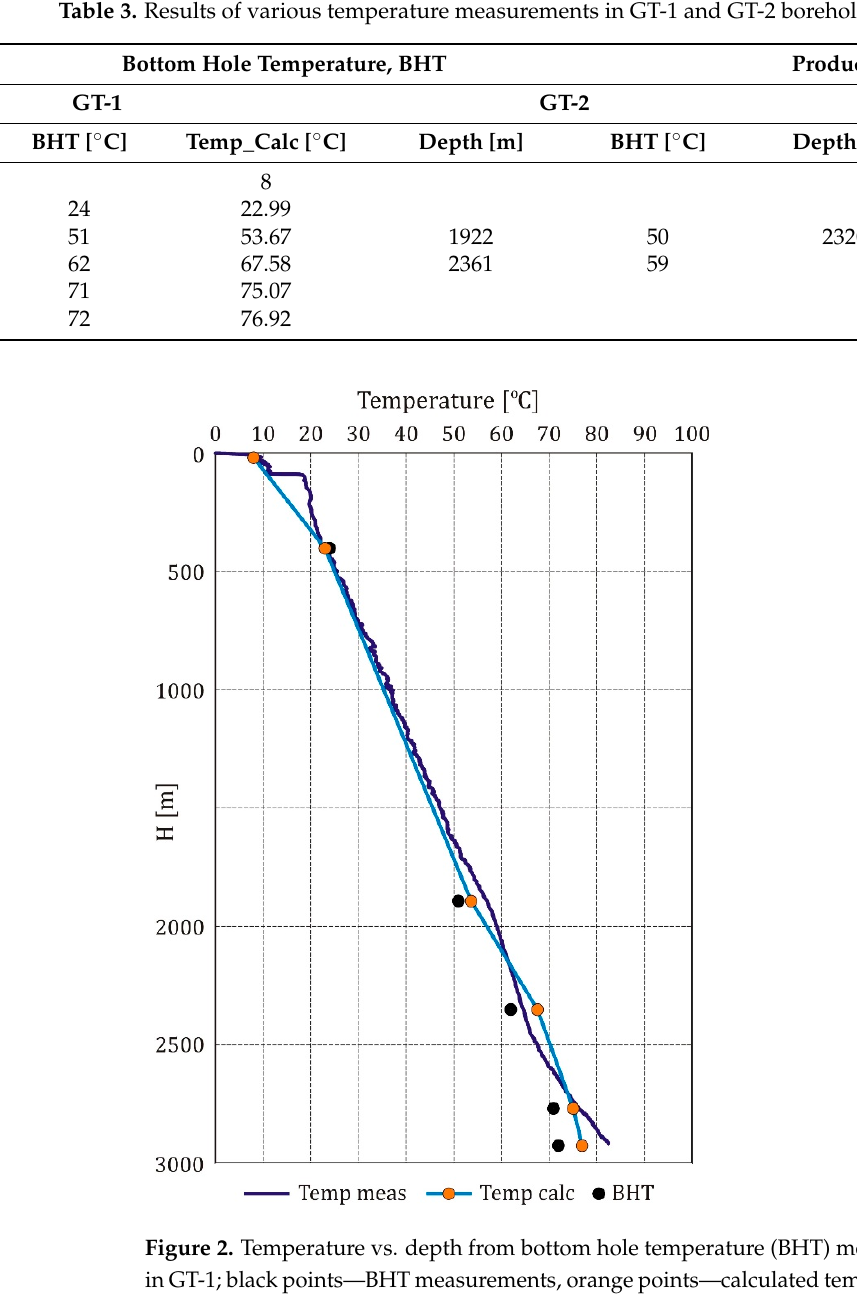
Table 3. Results of various temperature measurements in GT ‐ 1 and GT ‐ 2 boreholes.